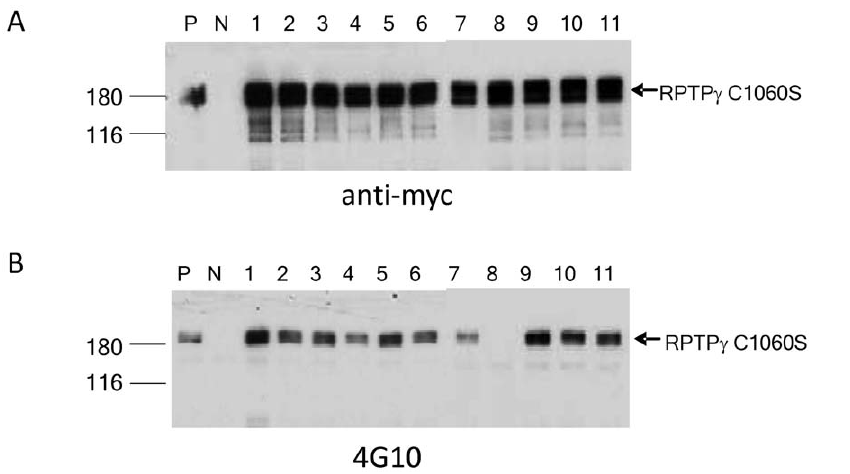
Figure 7. Identification of tyrosine residue at amino acid 1307 (Y1307) as auto-dephosphorylation site. There are a total of eleven tyrosine residues that can be found in D2 domain (figure S1). Each of these tyrosine residue was individually mutated to phenylalanine by PCR on the parental plasmid pCDNA3.1 RPTP c C1060S. We then performed transfection of pcDNA3.1 RPTP c C1060S (lanes ‘‘P’’ in panels A and B) and the 11 different pcDNA3.1 RPTP c C1060S/Y- . F mutants (lanes1 to 11 in panels A and B) to HEK293 cells. Lane ‘‘N’’ is vector control only. The immunoprecipitates by anti-myc were loaded to SDA-PAGE and subjected to western blot by anti-myc (A) and anti-4G10 (B). The results revealed that all mutants but RPTP c C1060S/Y1307F (lane 8 in panel B) contained tyrosine-phosphorylation reacted to antibody 4G10 (B). We concluded that Y1307 is the tyrosine residue that was phosphorylated, by activity of an unknown kinase, and then dephosphorylated by active RPTP c .